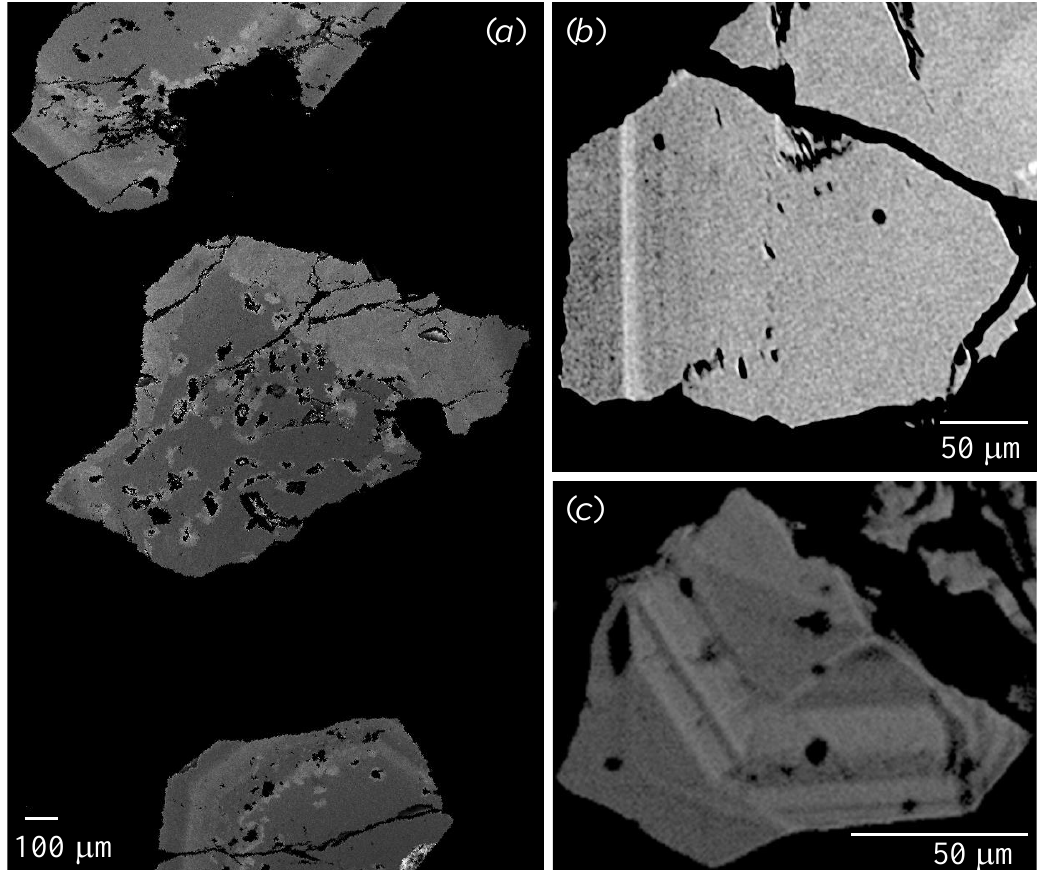
Figure 3. Back-scattered electron (BSE) images showing well-defined lamellar features in all the images. ( a ) Uv sample 1 from Russia-A, ( b ) Uv sample 3 from Russia-B, and ( c ) Uv sample 5 from California. The crystals in (a) also contain patchy features that arise from dissolution and re-precipitation. The scale bars are shown.